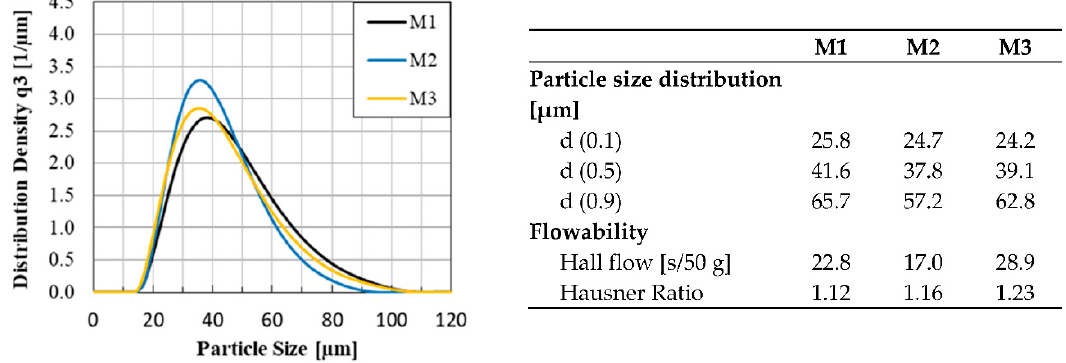
Figure 3. Powder blends characteristics of M1 (black), M2 (blue) and M3 (yellow) ( left : diagram, right : numbers).